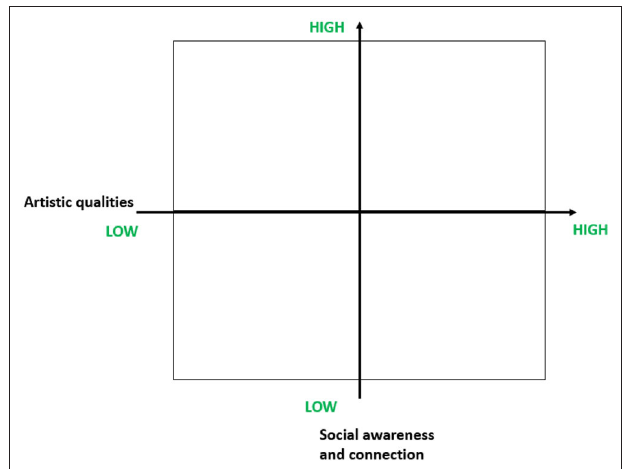
FIGURE 1 | Combining artistic and social dimensions of quality in